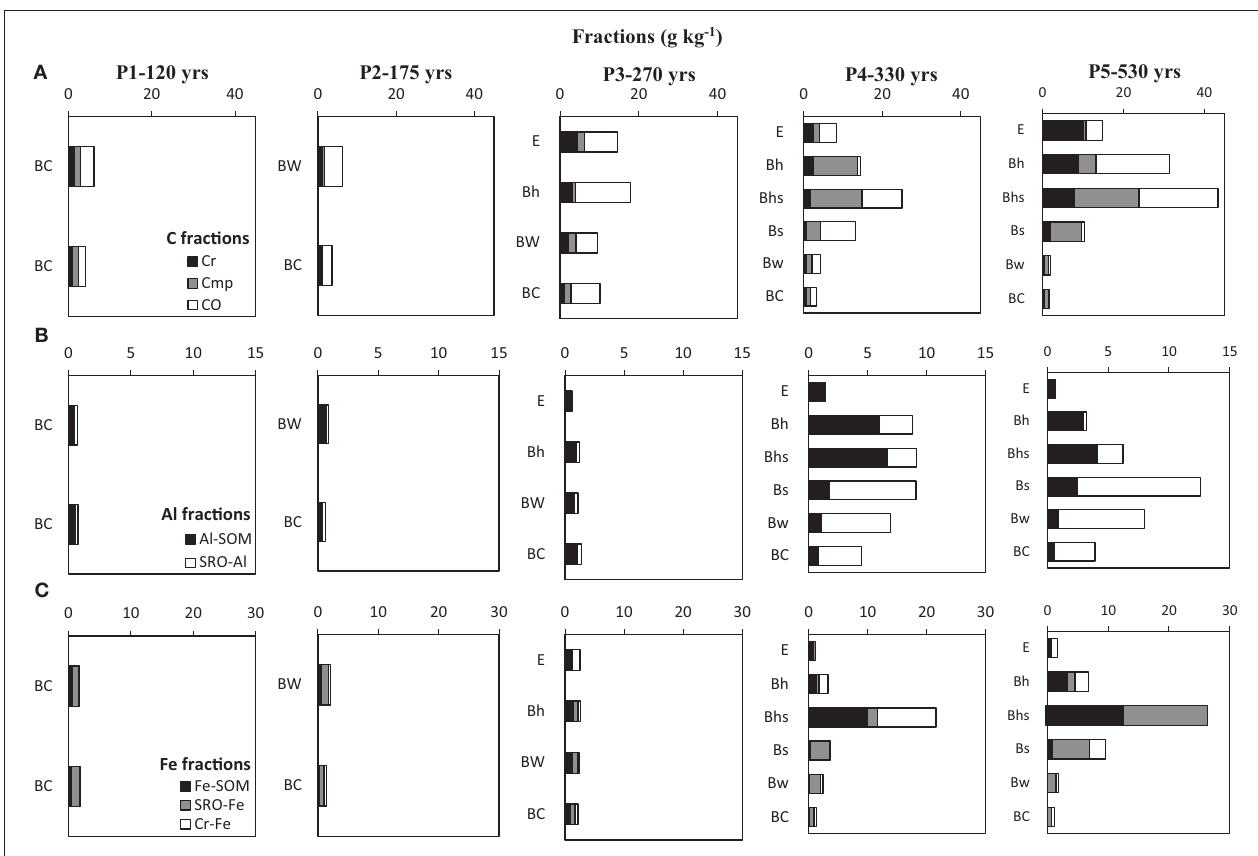
FIGURE 2 | (A) C fractions: recalcitrant C (C R , the non-extractable organic carbon after NaOCl and HF treatment), mineral-protected C [C MP , calculated by subtracting the C R fraction from the stable C fraction (C S , carbon left after NaOCl treatment)], oxidizable C [C O , calculated by subtracting Cs from the total C (C T )]. C R + C MP + C O = C T . (B) Al fractions: pyrophosphate-extractable Al (Al-SOM) and Al in short range ordered Al phases (SRO-Al = Al o -Al p ). (C) Fe fractions: pyrophosphate-extractable Fe (Fe-SOM), Fe in short range ordered Fe phases (SRO-Fe = Fe o -Fe p ), Fe in crystalline Fe phases (Cr-Fe = Fe d -Fe o